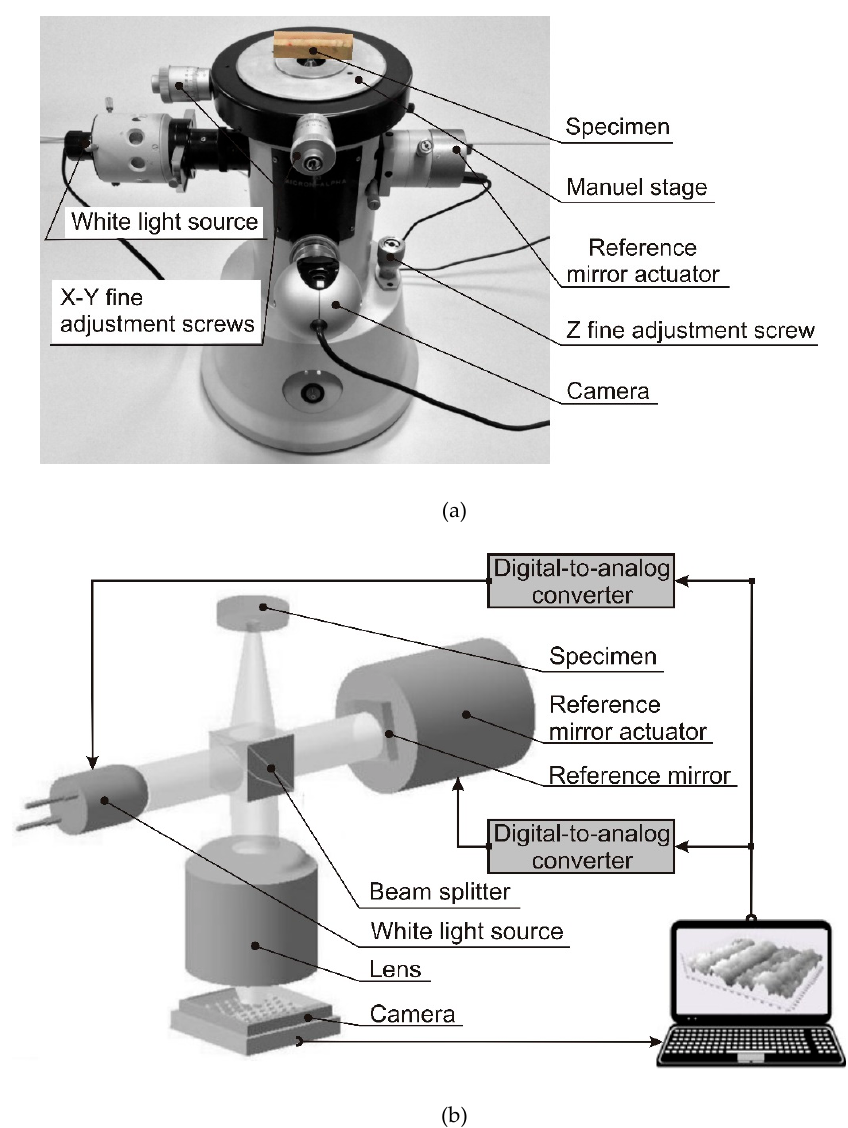
Figure 2. General view ( a ) and schematic diagram ( b ) of the three-dimensional interference